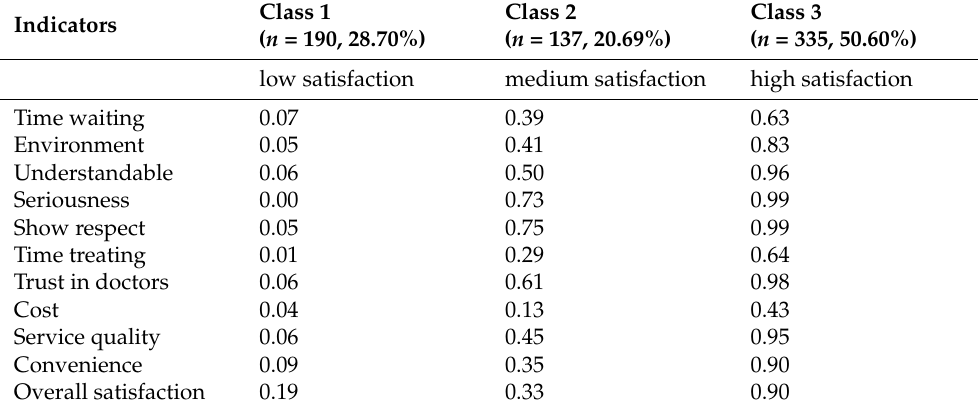
Table 5. Conditional probability of “good” patient satisfaction indicators in the 3-class model.